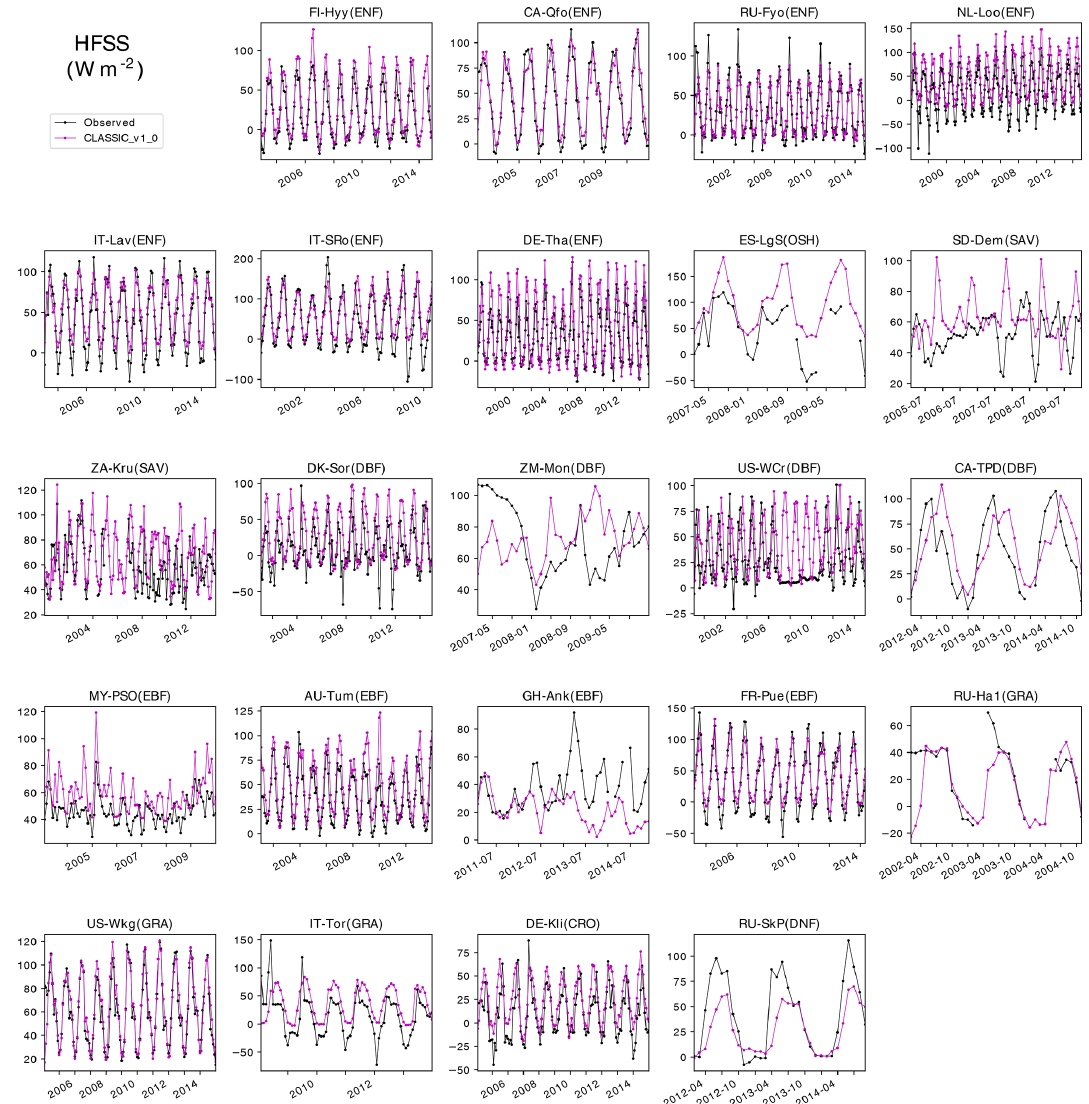
Figure 7. Monthly observed and simulated sensible heat fluxes for 23 FLUXNET sites. See caption of Fig. 5 for biome names. Shaded regions indicate the standard deviation across the sample years. Table 1 lists the full site